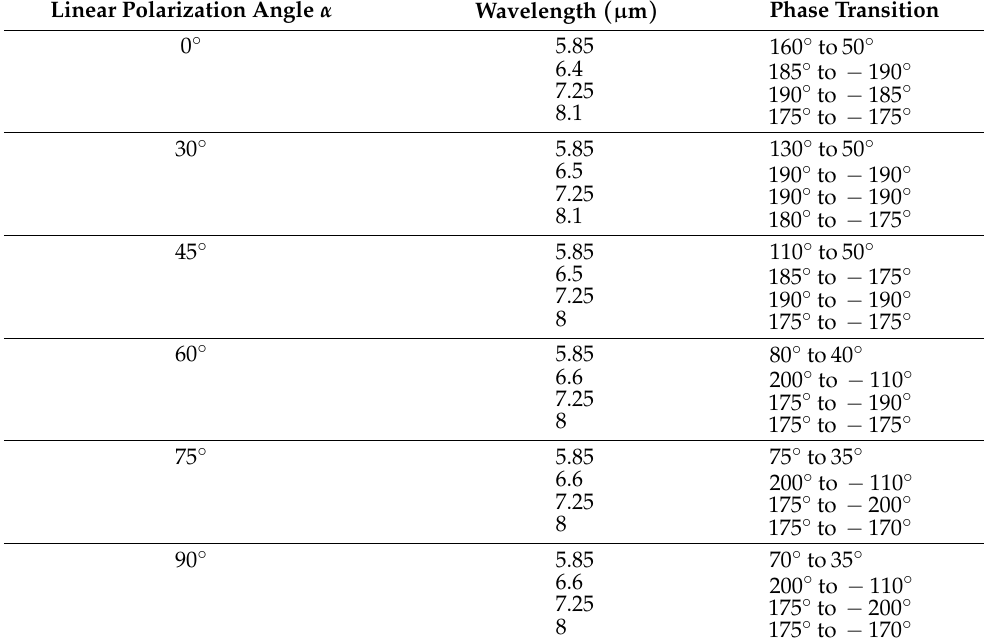
Table 7. Phase transitions associated with the reflected wave across the spectrum in the case of structure 3C, at linear polarization states defined by α = 0 ◦ , α = 30 ◦ , α = 45 ◦ , α = 60 ◦ , α = 75 ◦ and α = 90 ◦